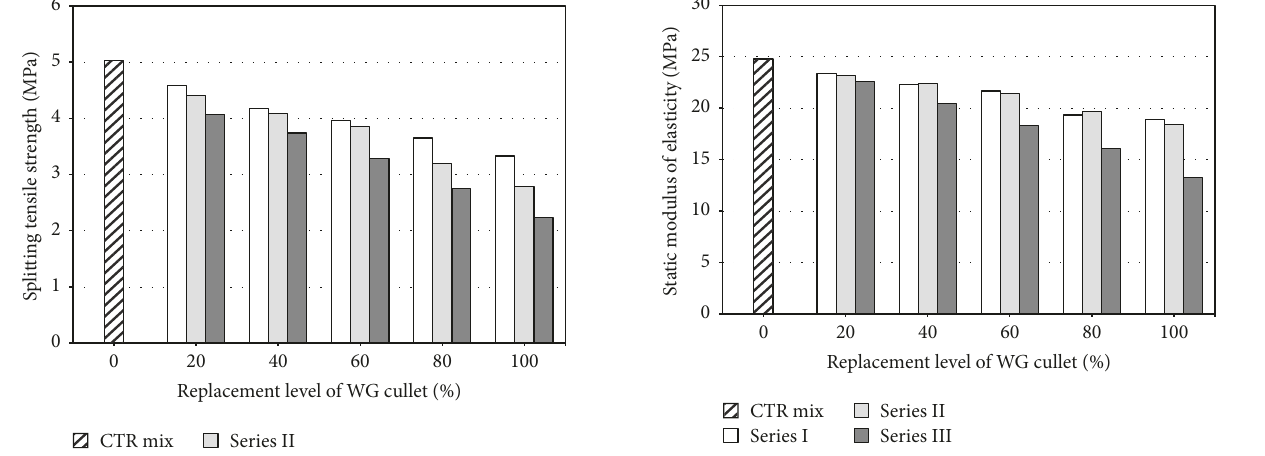
Figure 7: Modulus of elasticity of SCC mixtures at 28 days with respect to WG cullet